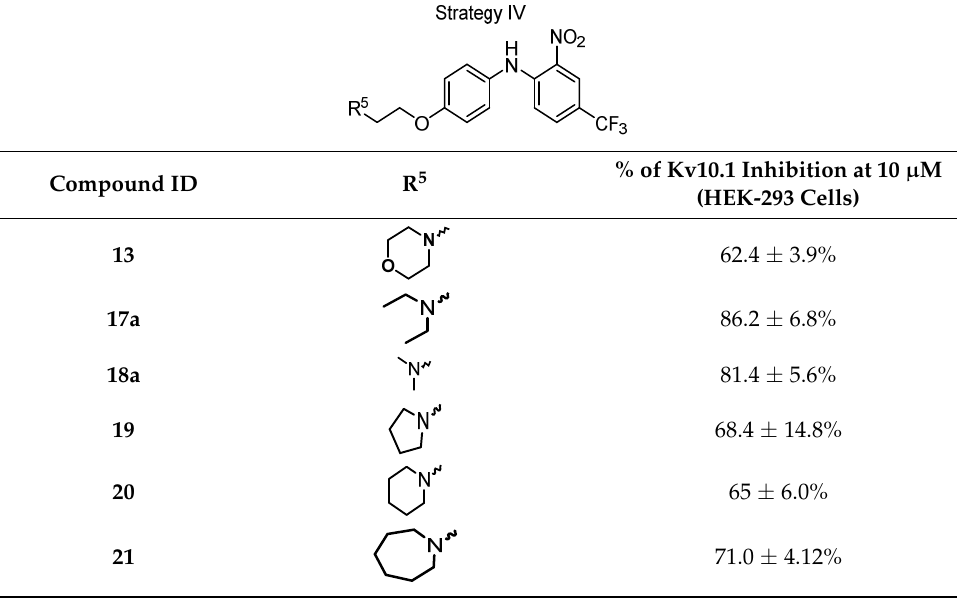
Table 4. Structures and potencies of compounds from Strategy IV.